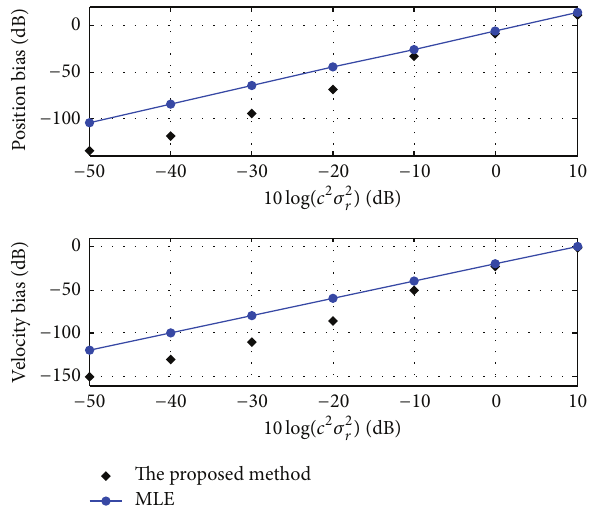
Figure 8: Comparison of the estimation bias of the proposed method with the original MLE against the Gaussian TDOA and FDOA noise for far-field source. The result is shown in log scale as the noise power